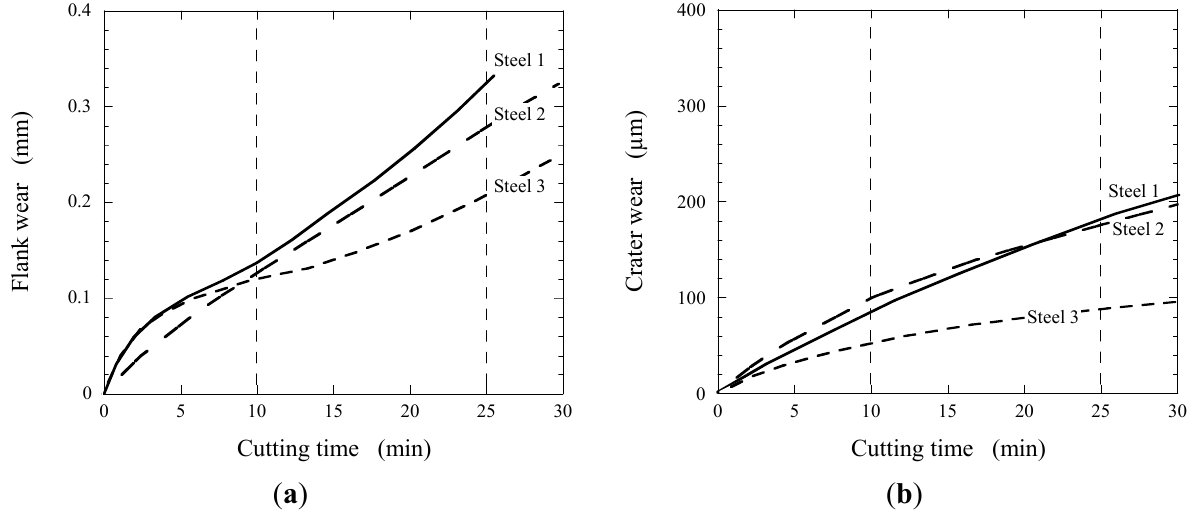
Figure 23. ( a ) Flank wear; and ( b ) crater wear progressions in turning test for AISI 316L steel with different non-metallic inclusions: (1)—alumina (Al 2 O 3 ); (2)—gehlenite (2CaO·Al 2 O 3 ·SiO 2 ); and (3)—anorthite (CaO·Al 2 O 3 ·2SiO 2 )